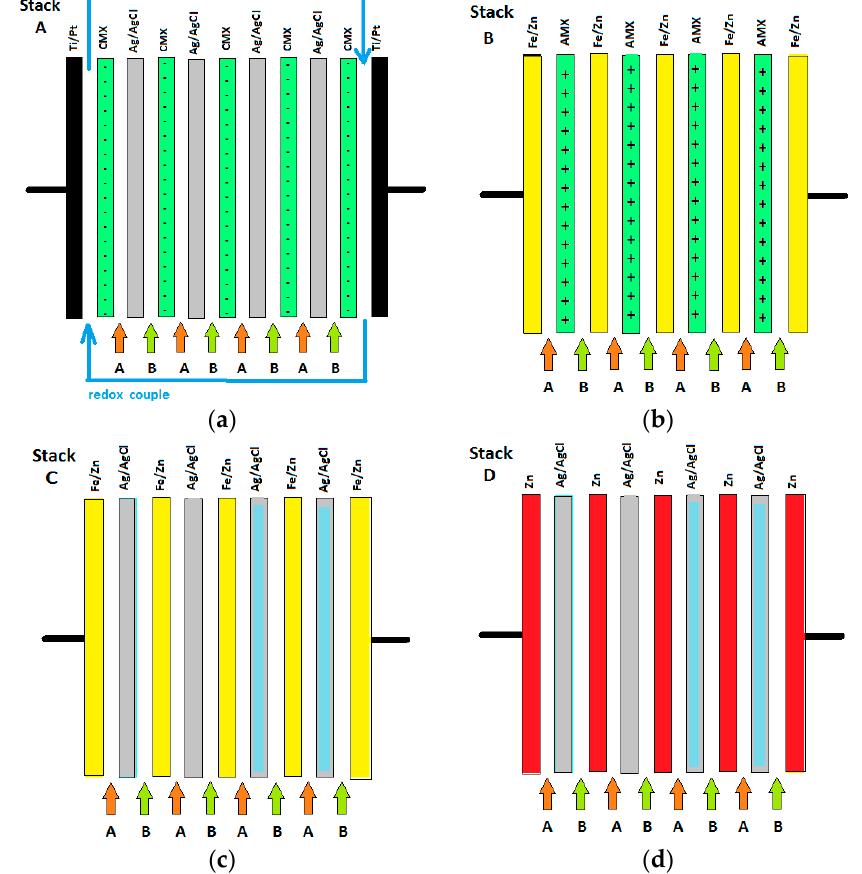
Figure 2. The four tested stacks: stack A ( a ); stack B ( b ); stack C ( c ) and stack D ( d ). Feed water solutions are indicated by A and B.